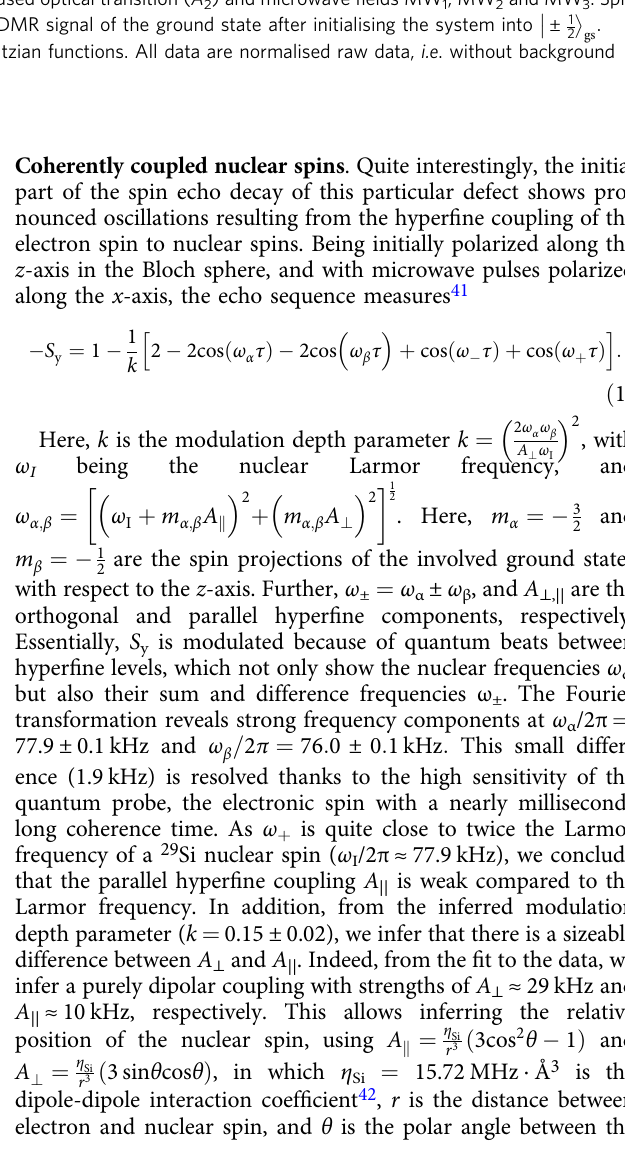
(cid:1) (cid:3) (cid:1) . 2 gs